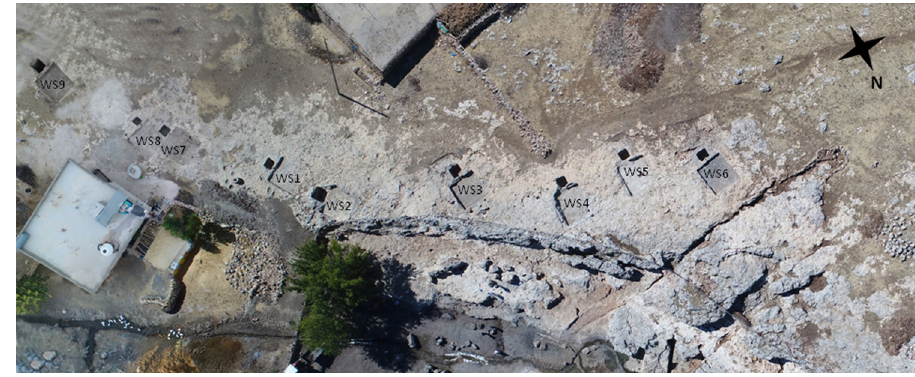
Figure 2: Drone image of the Ambarçay Complex ( Ambarçay Salvage Excavation Archive )